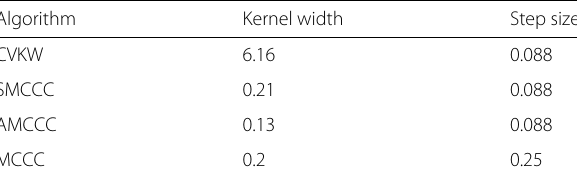
Table 1 Kernel size σ and step size μ used in the simulations for each tested algorithm